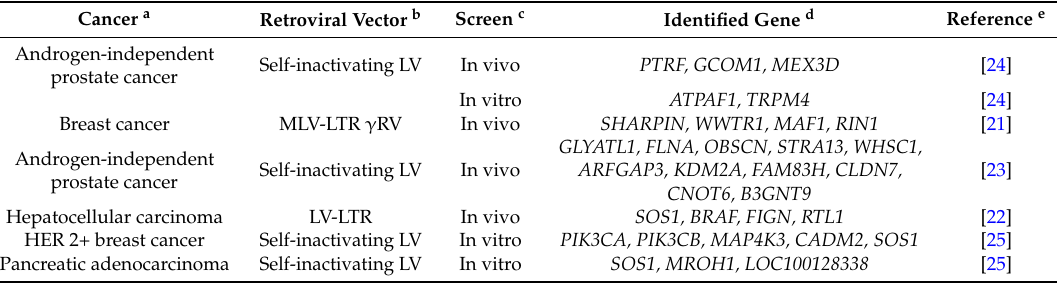
Table 1. Potential cancer driver genes identified by retroviral insertional